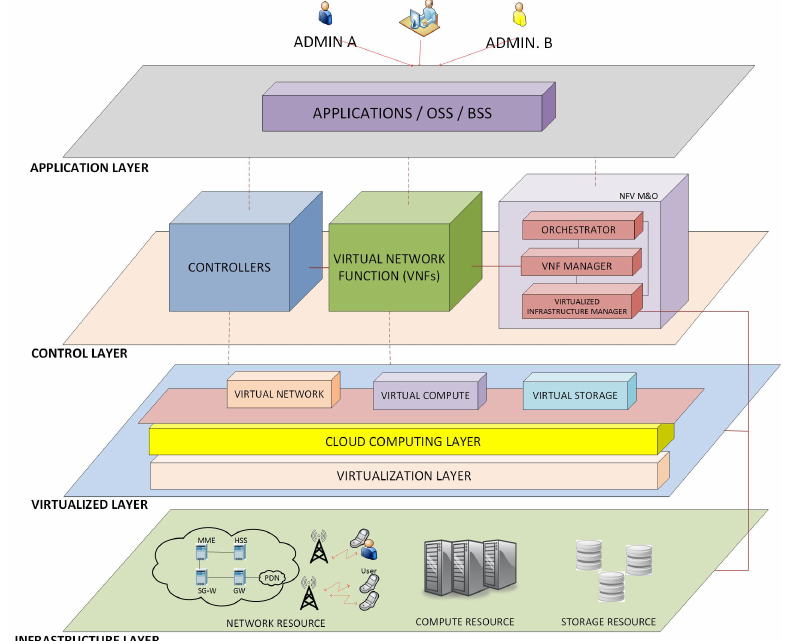
Figure 4. Future Network